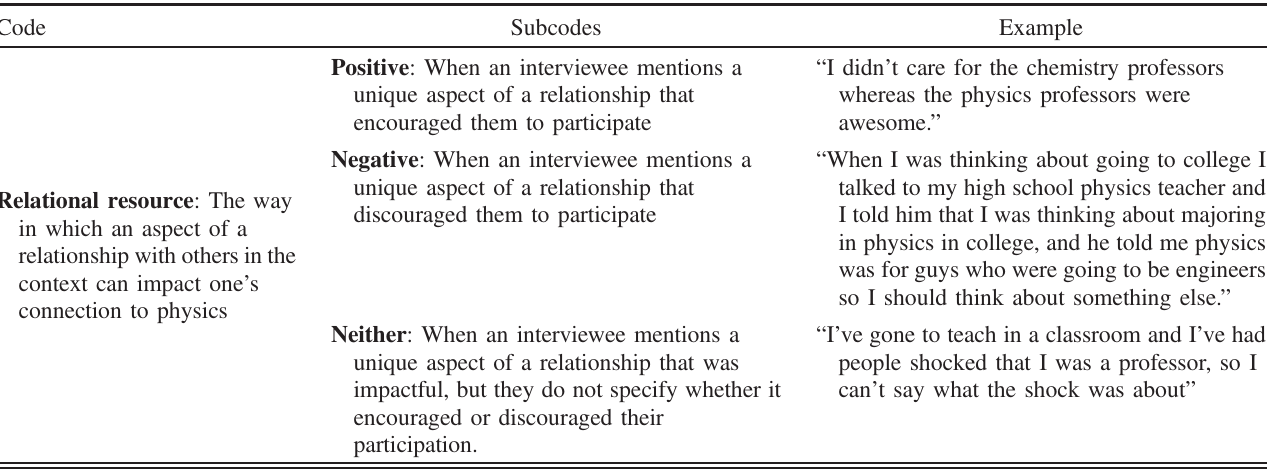
TABLE I. Details of our relational resource construct code definitions. This includes the definition of the main construct, as well as the definitions of each subcode and example from the interviews of Cara, Jeff, Cindy, or Owen. Code Subcodes Example